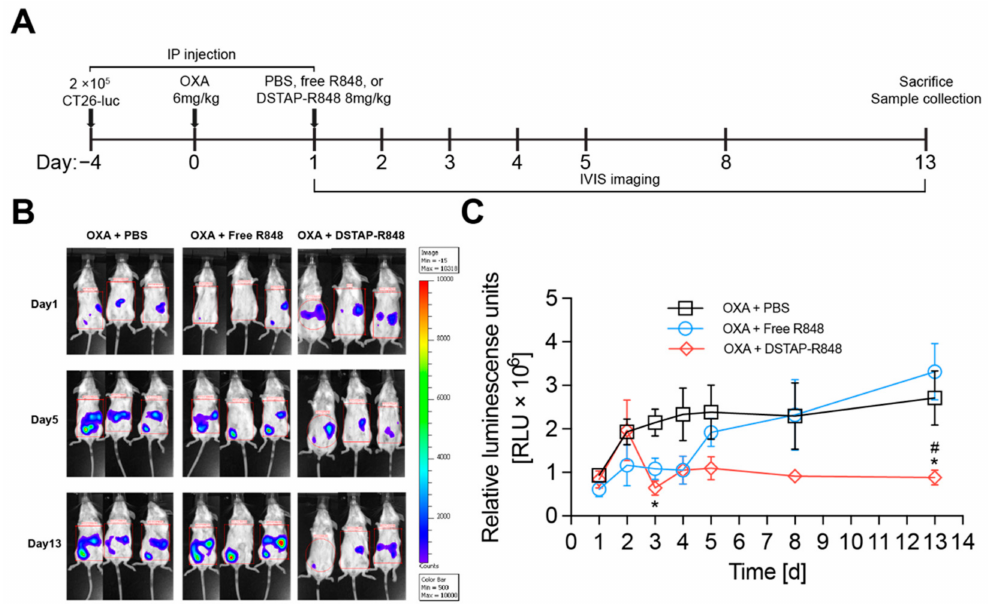
Figure 4. In vivo efficacy against a PC model of CT-26-Luc in female BALB/C mice. ( A ) Treatment sched- ule diagram. ( B ) Representative bioluminescent images of mice in different treatment arms. ( C ) Quantita- tive data of CT26-Luc bioluminescence in mice after different treatments. (Data = mean ± SEM, n = 5 − 6) *: p < 0.05 relative to PBS and #: p < 0.05 relative to free